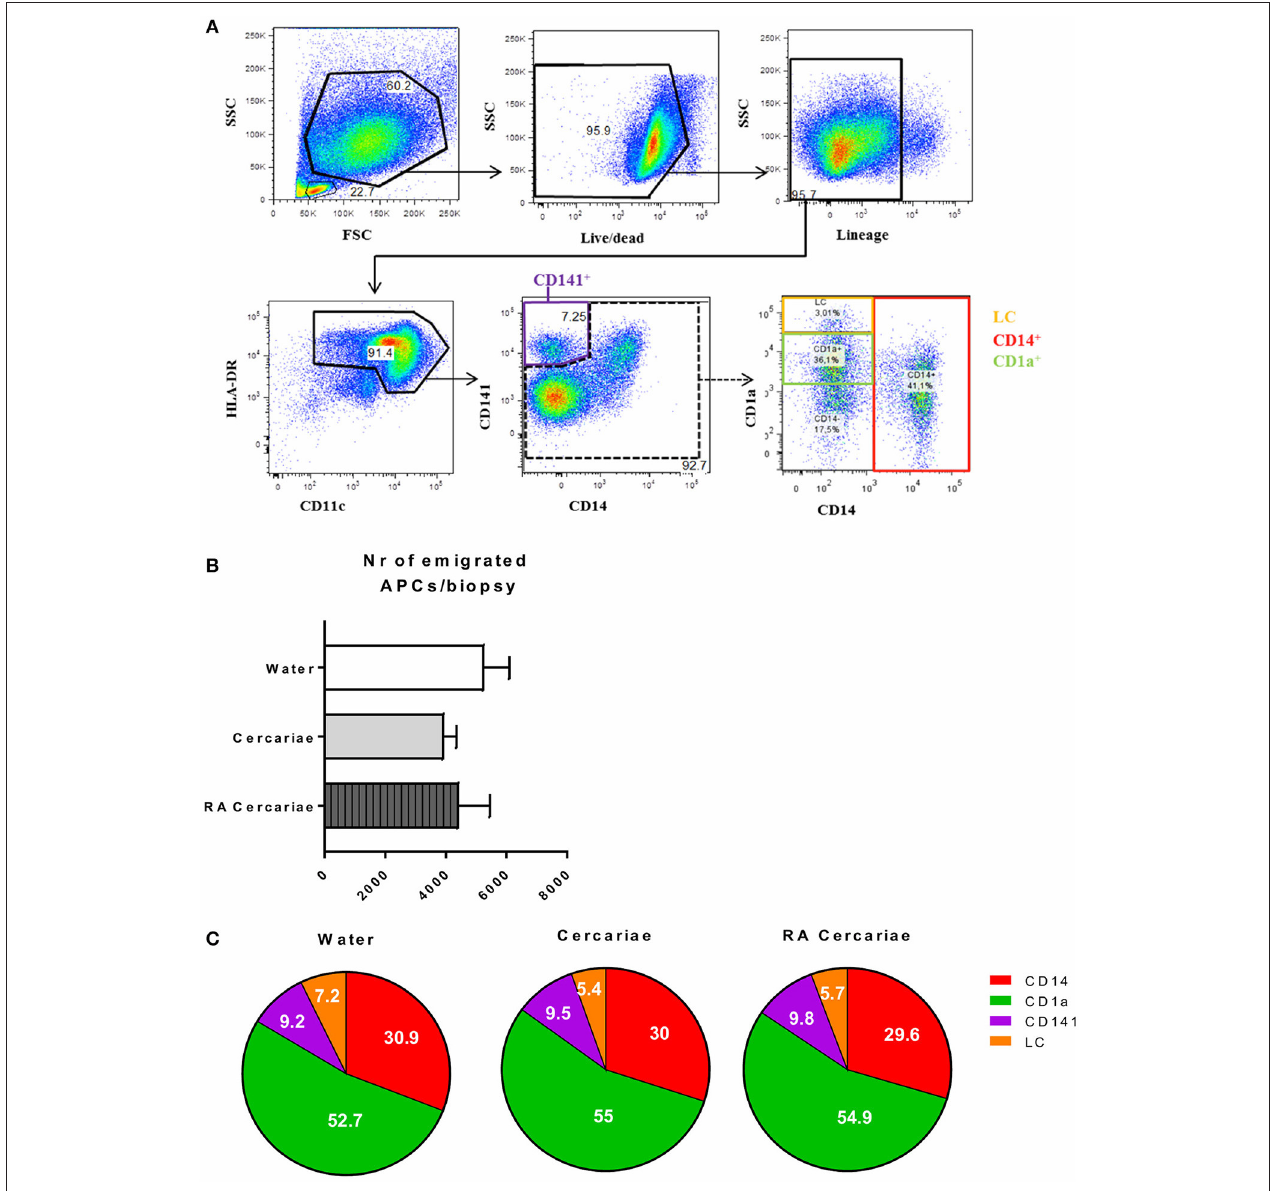
FIGURE 3 | S. mansoni cercariae do not induce DDC emigration from the skin. DDC gating strategy. Antigen presenting cells are selected by forward scatter (FSC) and side scatter (SSC) characteristics. Doublets are excluded (not shown). Live cells are gated and selected for the lack of lineage markers (CD56, CD3, CD19, CD20). APCs are selected on the expression of HLA-DR as well as intermediate to high levels of CD11c. HLA-DR + , CD11c + cells can be divided into the different DDC populations: CD141 + , LC, CD1a + and CD14 + (A) . Total emigrated HLA-DR + , CD11c + antigen presenting cells from dermal biopsies at 3 days post exposure to S. mansoni cercariae or water control. Mean ± SEM, n = 7 ( B ). Subset distribution of emigrated cells ( C ).